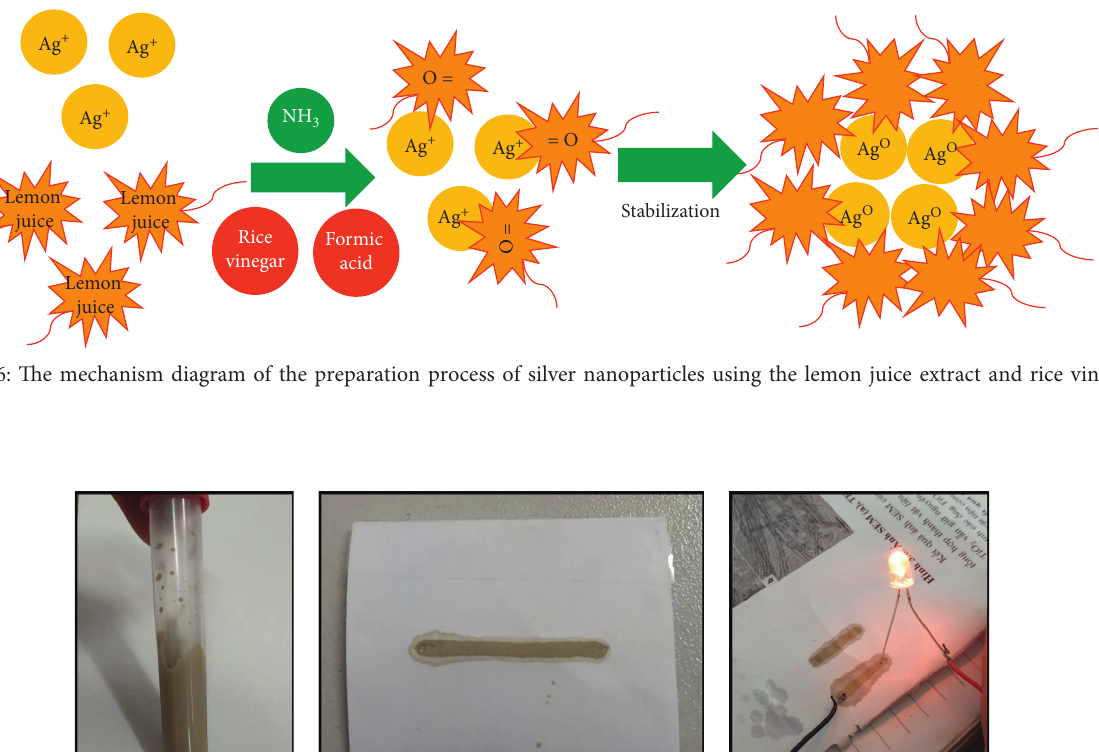
Figure S1: absorbance spectra of (a) lemon extract and (b)